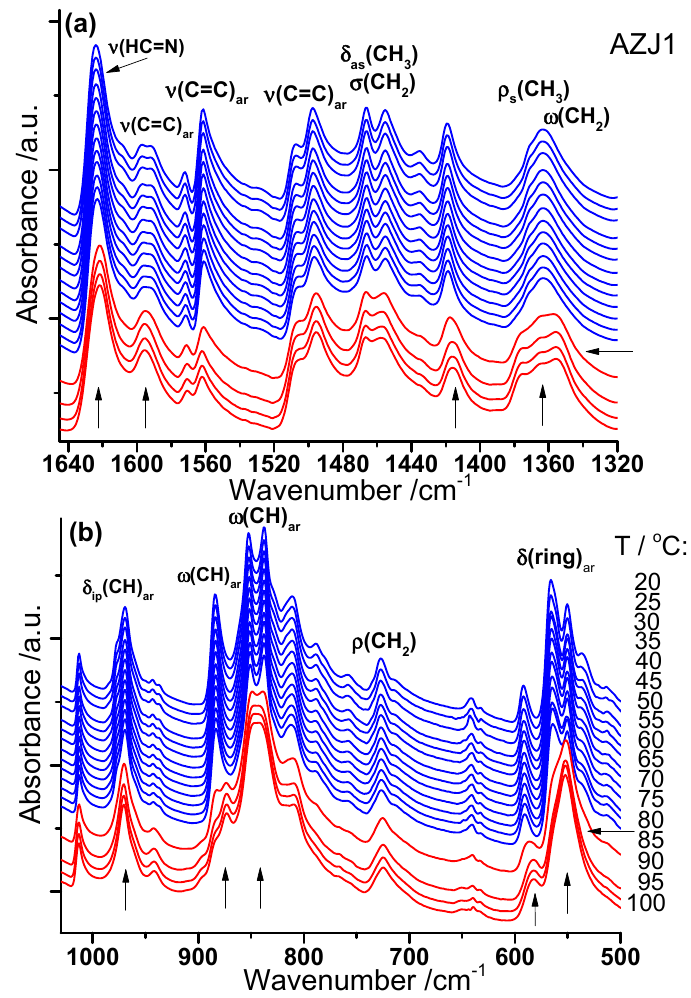
Figure 3. Temperature evolution of the FT-IR spectrum of AZJ1 obtained during heating in two spectral ranges: ( a ) 1645–1320 cm − 1 and ( b ) 1030–500 cm − 1 . Ordered and liquid crystal phases are marked blue and red, respectively. The most changed bands upon the transition are marked with vertical arrows.